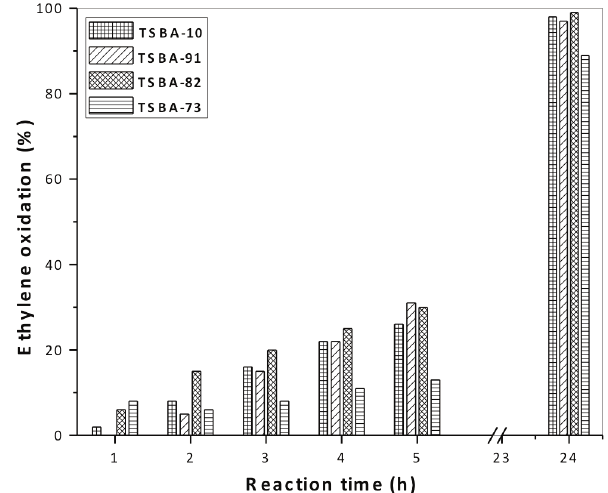
Fig. 6 - Histogram showing the ethylene oxidation efficiency of four catalyst samples with the reaction time under UV